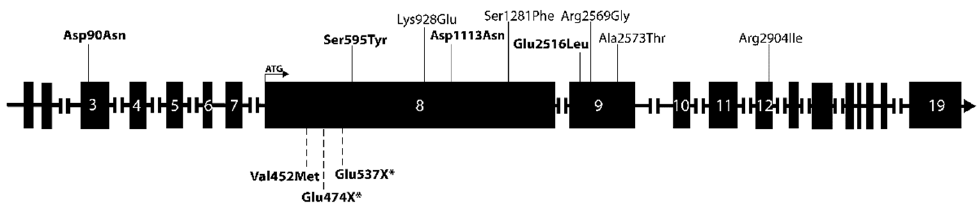
Figure 2. Schematic depiction of the PRUNE2 gene and its exons. PRUNE2 variants found in our cohort are annotated above the gene, and previously identified PRUNE2 mutations (somatic and germline) in PC patients are annotated below the gene. The respective sizes of the exons are not to scale. Somatic mutations are marked with an asterisk (*). Mutations predicted to be damaging are marked in